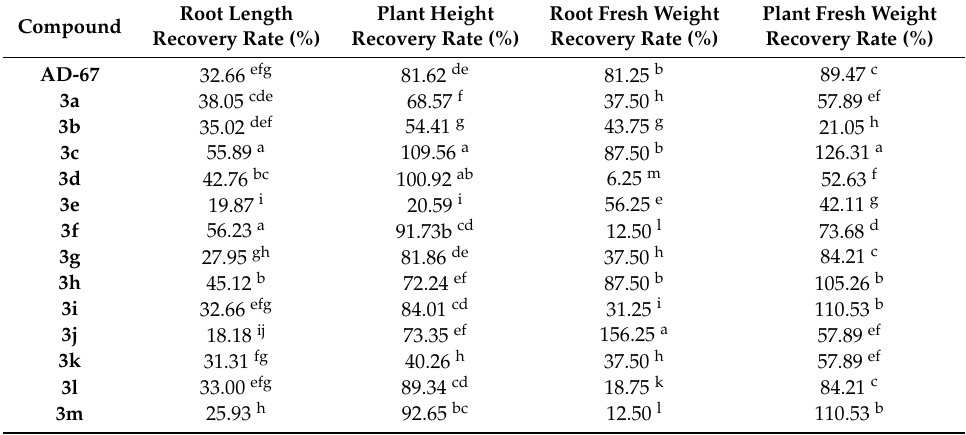
Table 2. Effect of detoxification of compounds 3a – m to growth index of maize i, ii, iii, iv .